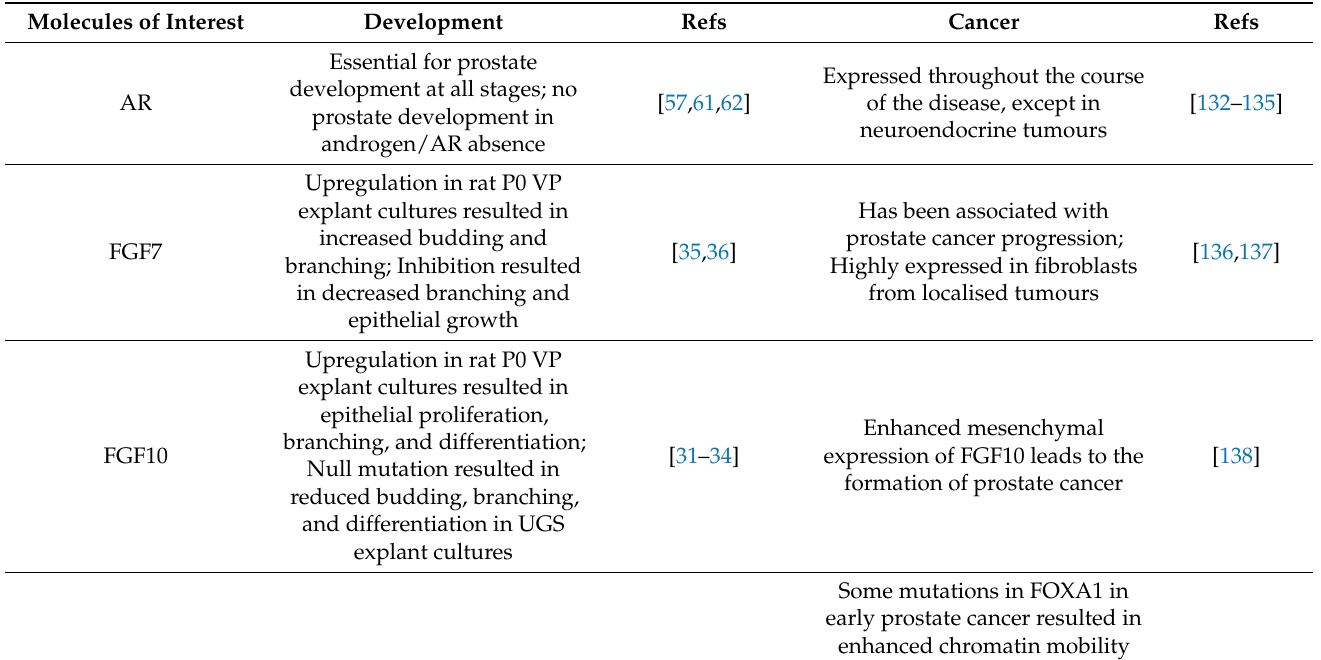
Table 1. Key molecular drivers of prostate development and their association with prostate disease. Other important factors are listed on Section